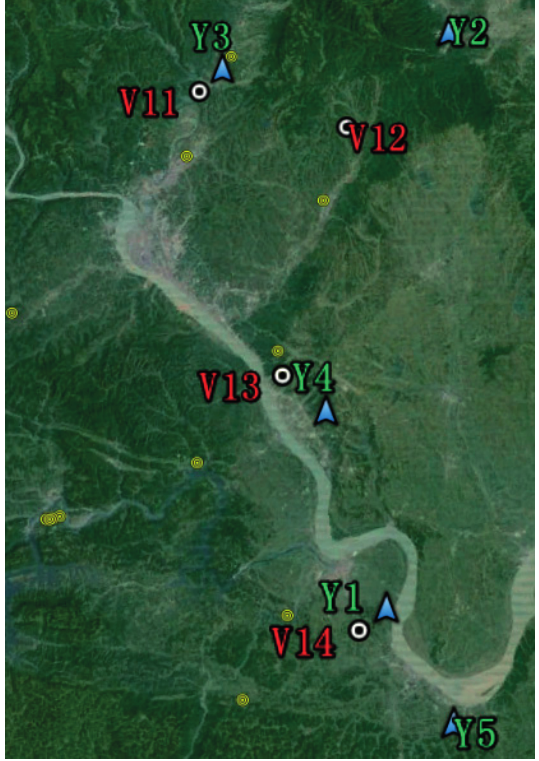
Figure 6. Distributions of six sites in an image of Yichang acquired by satellite. The legend is consistent with that of Figure 4. The yellow circles are other verification points which are far away from monitoring sites. The dimension of the area shown in Figure 6 is roughly 50 km by 80